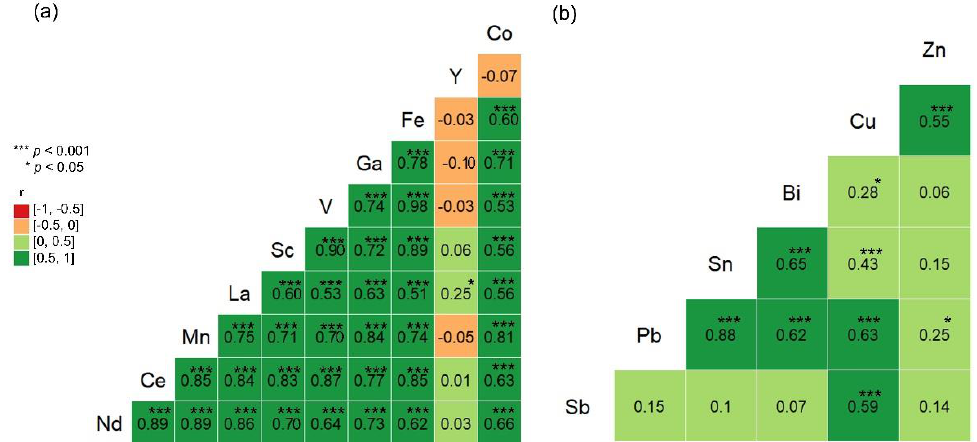
Figure 1. Pearson’s correlation coefficients calculated between air concentrations of all metals grouped in rotated component (RC)1 ( a ) and RC2 ( b ).